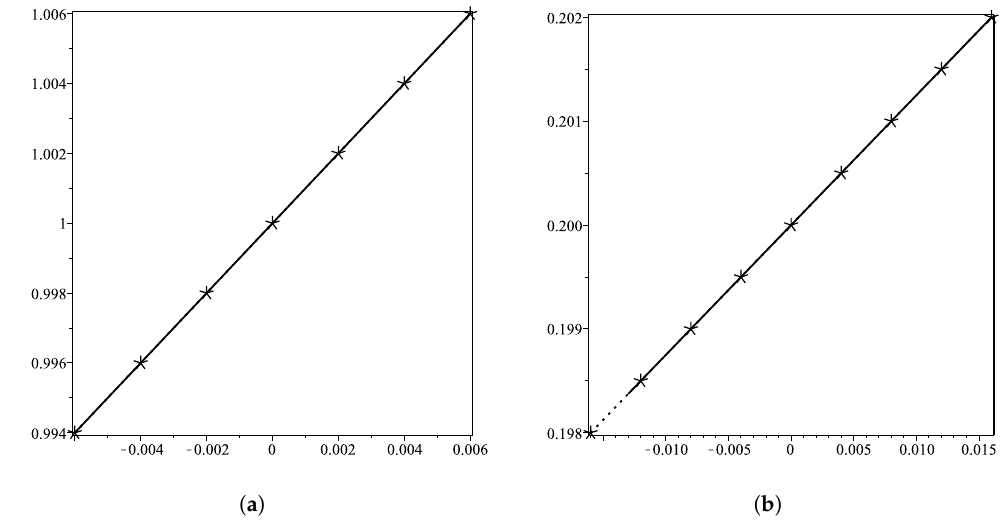
Figure 2. ( a , b ) show monotone curves generated by FP -scheme (1) using monotone initial data.